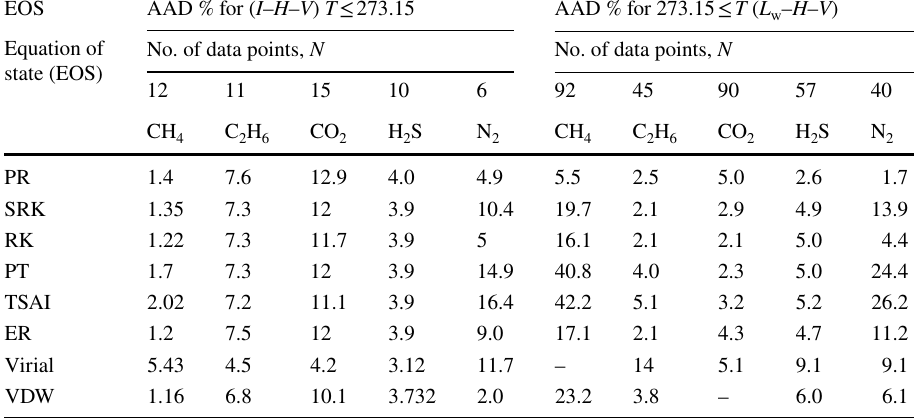
Table 7 Statistical error, AAD % for the ice–hydrate–vapor equilibria and liquid hydrate vapor